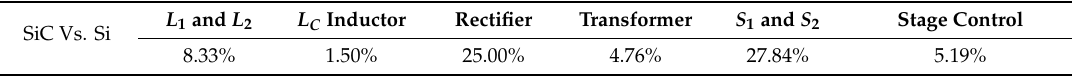
Table 7. Power reduction percentage; first vs. second